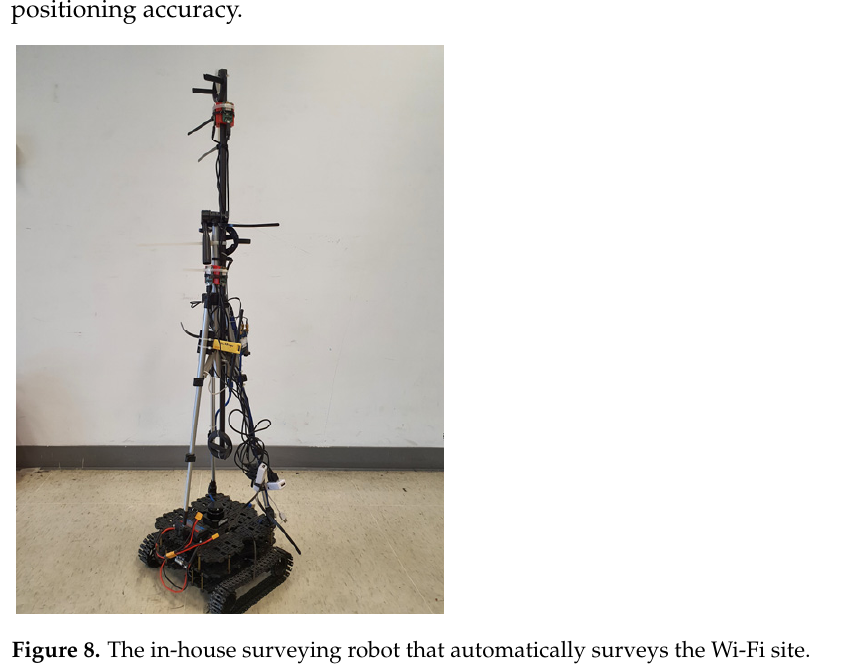
Figure 8. The in-house surveying robot that automatically surveys the Wi-Fi site.